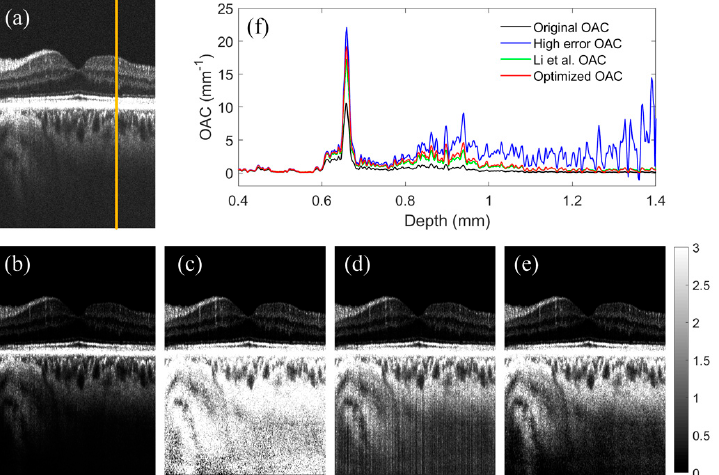
Figure 9. OAC calculation results using a di ff erent method. ( a ) A typical fundus OCT B-scan image. ( b – d ) The original OAC image, high-error OAC image, and Li et al. OAC image, respectively. ( e ) The optimized OAC image obtained using the algorithm in this paper. The unit of the colorbar is mm − 1 . ( f ) The comparison of the four OAC curves at the position of the solid orange line in ( a ).